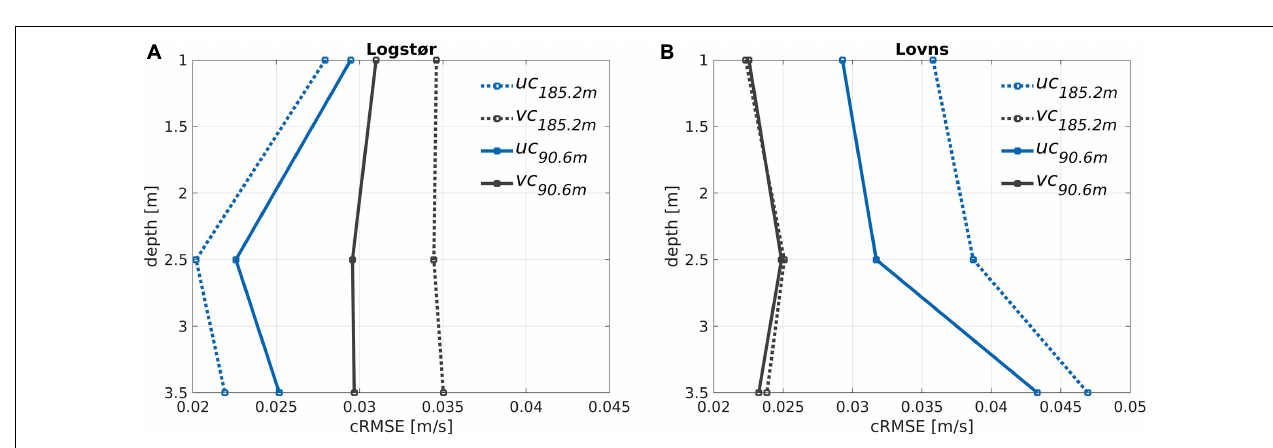
FIGURE 13 | Lovns: Zonal (A) and Meridional (B) winds at 10 m height (u10, v10) and surface currents (uc, vc). Modeled winds (blue) and observed winds (black) at Aars Syd (56 ◦ 48 (cid:48) 11.7 (cid:48)(cid:48) N, 9 ◦ 31 (cid:48) 3.9 (cid:48)(cid:48) E) and modeled surface currents (bright red) and observed currents (faint red) at Lovns. Full, red lines: double horizontal spatial resolution (92.6 m), dotted lines: standard resolution (185.2 m).